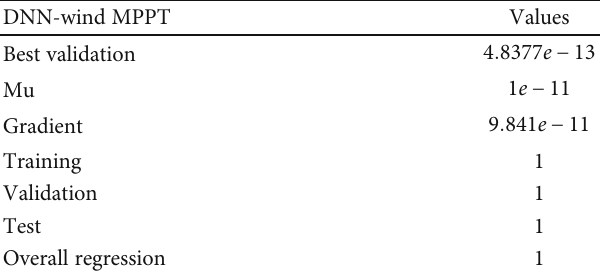
Table 1: DNN data of MPPT